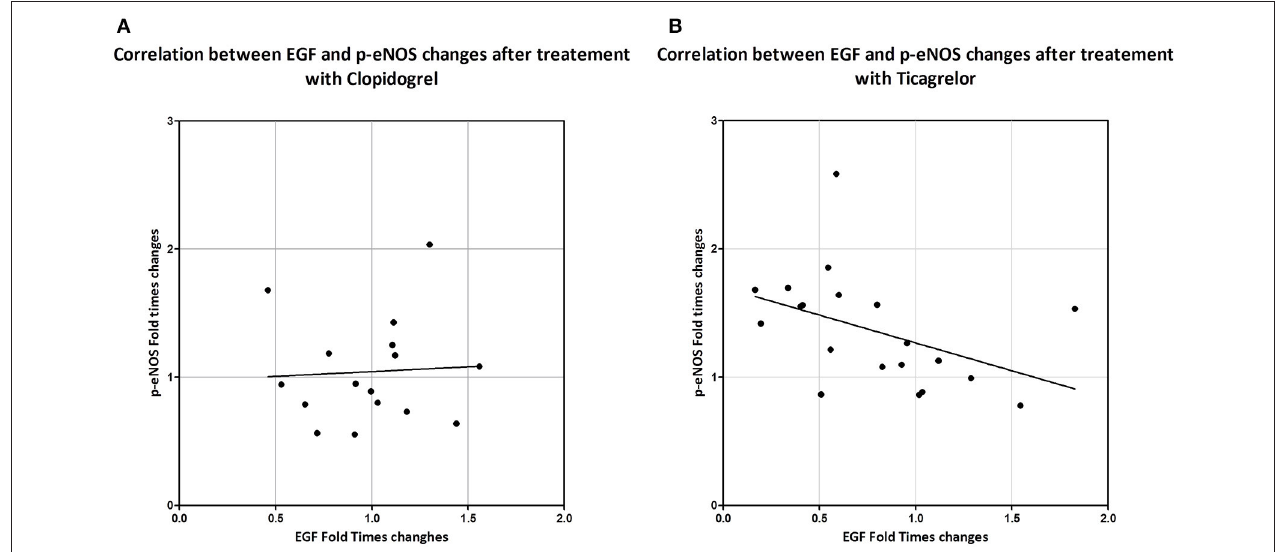
FIGURE 5 | Correlation between changes in levels of circulating EGF (ratio between EGF levels after 1 month of treatment and at baseline) and of p-eNOS in serum treated HUVEC (ratio between p-eNOS levels in HUVEC treated with patient’s sera after 1 month of treatment and at baseline) in patients treated with clopidogrel (A) or with ticagrelor (B) . Correlation was assessed by Spearman correlation test. Clopidogrel: R = 0.100; p = 0.714. Ticagrelor: R = − 0.571; p = 0.002.